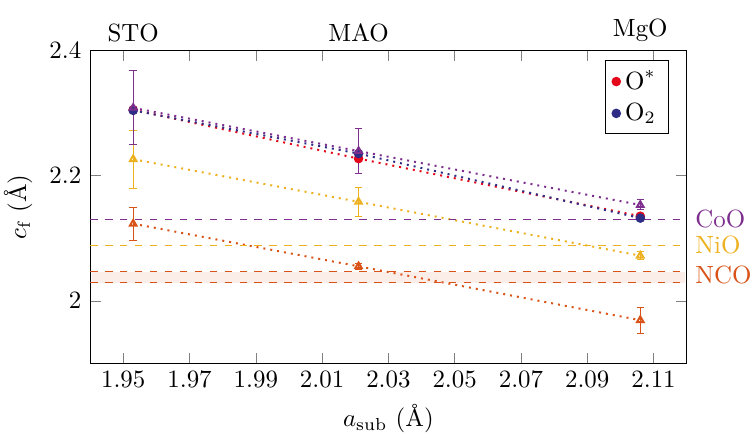
Figure 6. Vertical layer distance c f with respect to the lateral layer distance a sub of the used substrates determined by the oxide film peak position. Furthermore, the theoretical vertical layer distances for bulk CoO, NiO and NCO are displayed with dashed horizontal lines along with the expected vertical layer distances for pseudomorphic growth on the different substrates